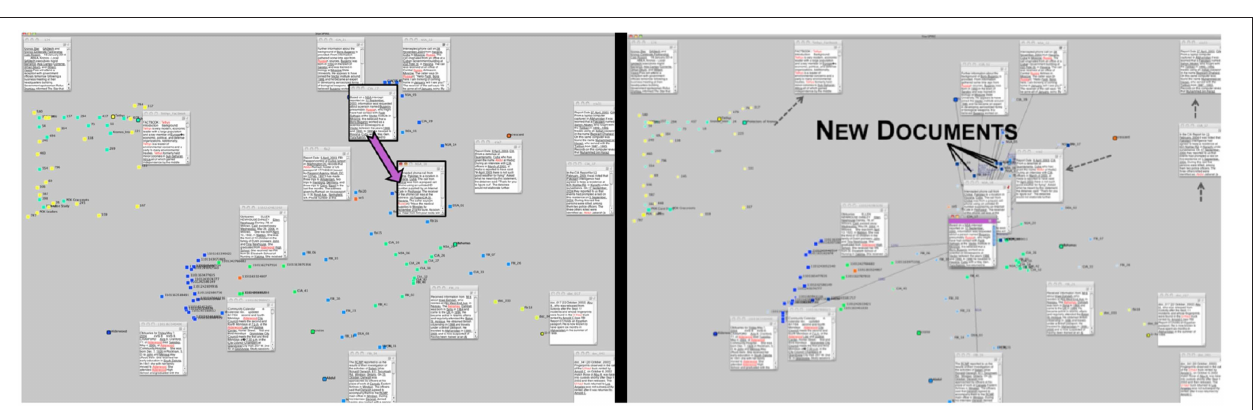
FIGURE 6 | In StarSpire, a cluster created by the analyst (Left) is filled with more relevant documents by the system (Right) (Bradel et al., 2014).